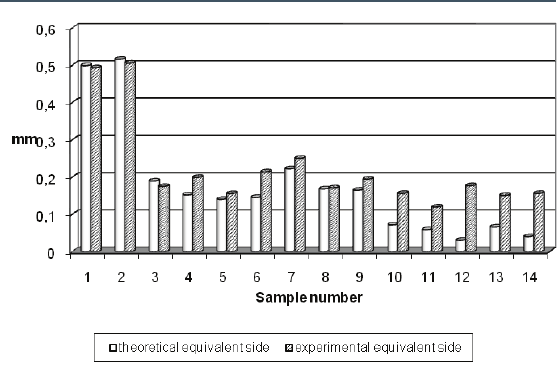
Figure 7. Square shape of the pores: comparison between theoretical and experimental equivalent side of the square.